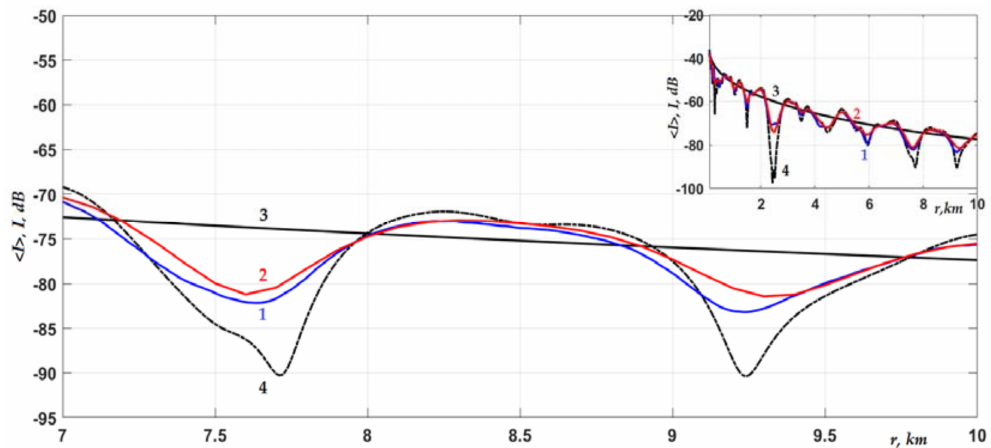
Figure 8. Similarly to Figure 7, the average intensity, but near the bottom. z = z 0 = 36 m. Curves: 1 is OW solution, L h = 100 m; 2 is OW solution, L h = 1 km; 3 is intensity I in the unperturbed waveguide ( δ h = 0), averaged over the interference scale; 4 is intensity I in the unperturbed waveguide ( δ h = 0).